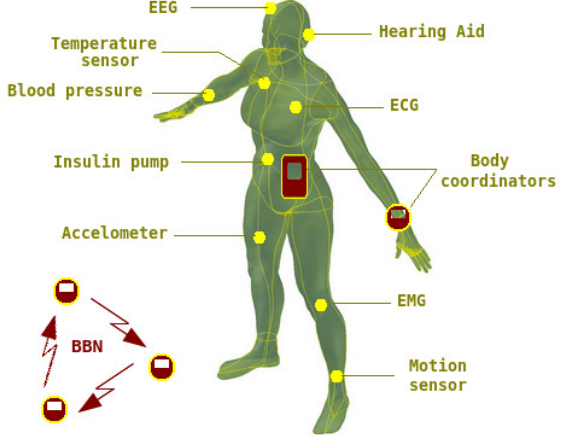
Figure 1. Example of a patient monitoring using a wireless body area network